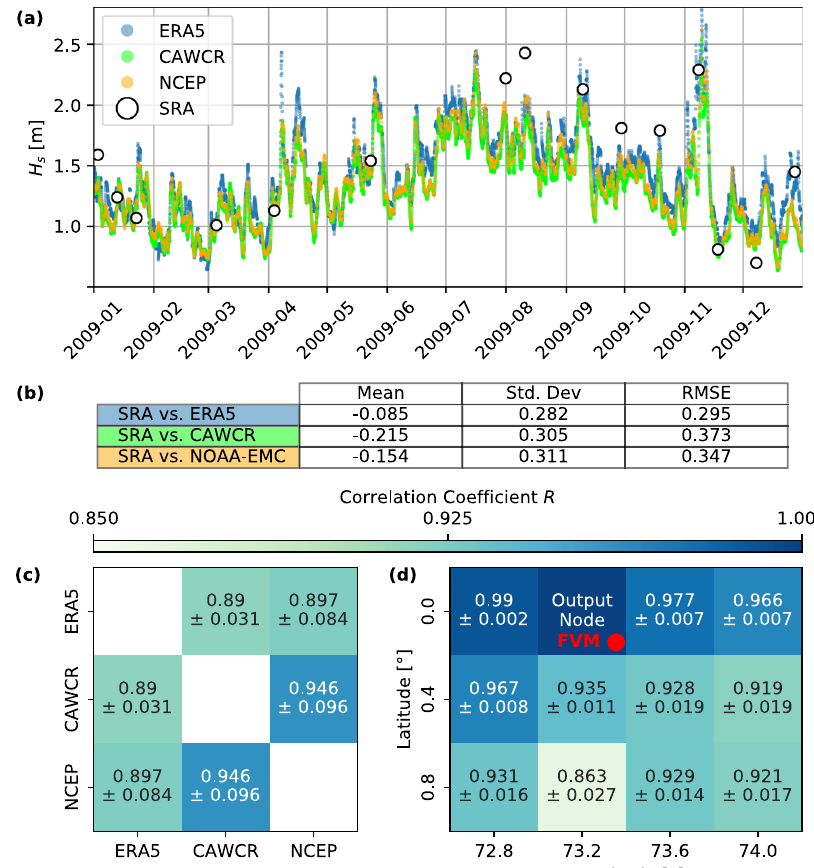
Fig. 4 Time series of local wave data in comparison to regional and projected future wave data. a Typical time series of the signi fi cant wave height H s for each data set over one year (here 2009). The data sets are provided through the climate data repositories of the European Centre for Medium-Range Weather Forecasts (ECMWF), the Collaboration for Australian Weather and Climate Research (CAWCR) and the National Center for Environmental Protection (NCEP) of the United States National Oceanic and Atmospheric Administration (NOAA). White dots are Satellite Radar Altimetry (SRA) measurements of H s , recorded in the vicinity of the data output node. b shows the deviation between data sets and the SRA measurements c is a cross- correlation matrix for H s from each considered data repository between 1980 and 2019-05 (sample size n = 345,504 for ECMWF ’ s and CAWCR ’ s hourly data; sample size n = 115,168 for NCEP ’ s 3-h data). d is a spatial cross-correlation matrix for data nodes of the CAWCR data set adjacent to the output node considered in this study. The data nodes are in the center of each cell. Values in the matrix are mean μ R and standard deviation ± σ R of the correlation coef fi cient R . The red dot marks the location of Fuvahmulah within the